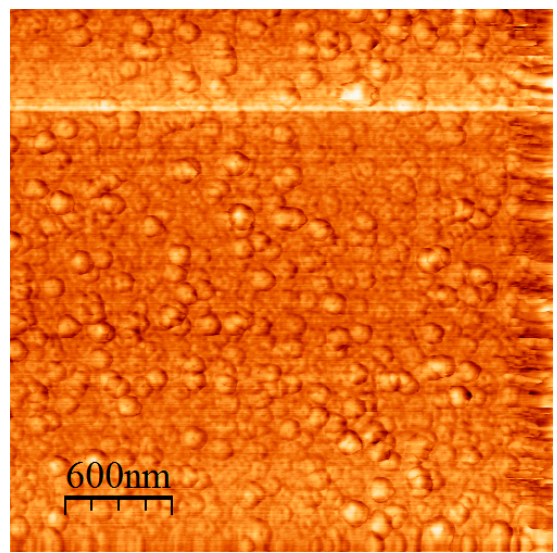
Figure 13. AFM height image of the block-graft copolymer.